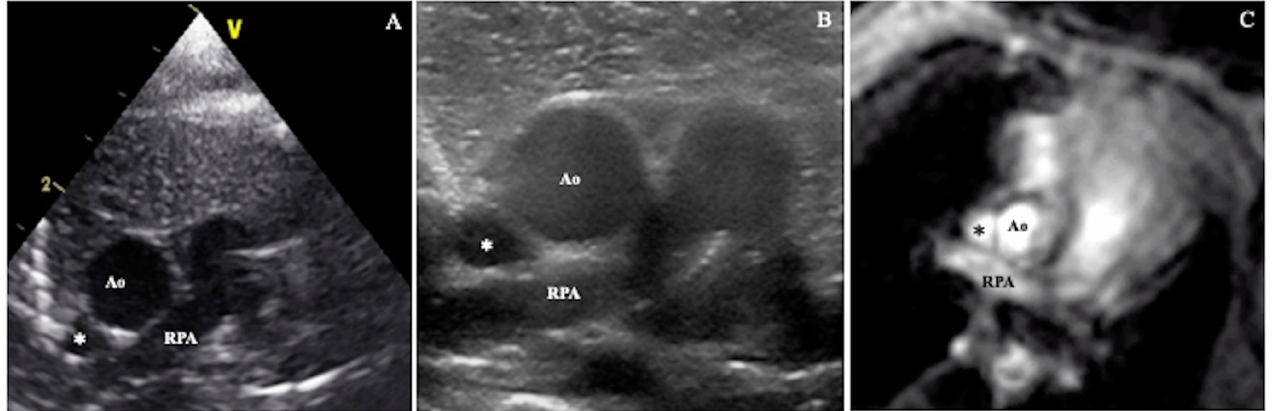
Figure 2. SVC cross-sectional area assessed by: ( A ) sector probe according to Method 2, ( B ) high frequency linear probe according to Method 3, ( C ) phase contrast magnetic resonance imaging . Ao = aorta, RPA = right pulmonary artery, * = superior vena cava .